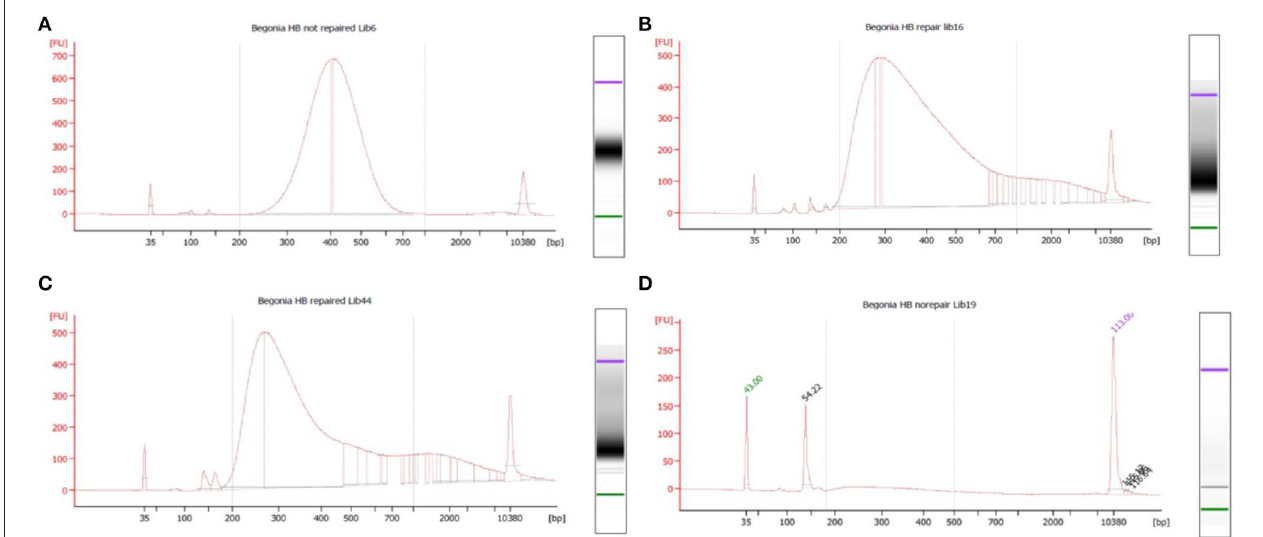
FIGURE 2 | Bioanalyser High Sensitivity DNA assays for representative libraries from each of the four capture pools, showing fragment size distribution. Base pairs (x-axis) and fluorescence units (y-axis) are shown on the graphs. The upper and lower size markers are represented in purple and green, respectively, on the gel image to the right of each graph. (A) B. bipinnatifida , Ambient, not repaired (pool 1—high quality). (B) B. trichopoda , Hair dryer, repaired (pool 2—left skewed). (C) B. serratipetala , Hair dryer, repaired (pool 3—profoundly left skewed). (D) B. trichopoda , Pickled, not repaired (pool 4—flat). A single adaptor peak is clearly visible on the graph and the gel image.